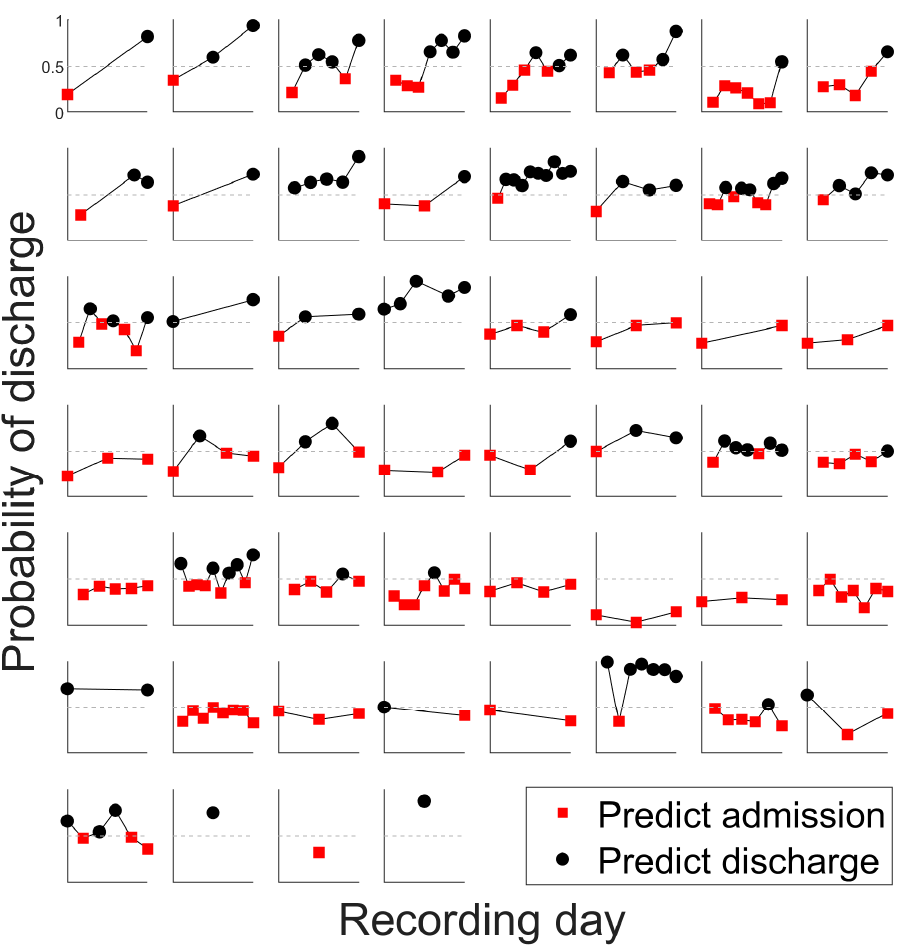
Figure 3. Day-to-day discharge probabilities for each patient based on the microphone-based MPT– model, with daily recording sessions on the horizontal axis of each subplot. Red squares indicate admission predictions (discharge probabilities below 0.5 threshold [dashed line]), and black dots indicate discharge predictions (discharge probabilities > 0.5). Participants are ordered ( left to right , top to bottom ) from the greatest to least first-to-last-day change in discharge probability.